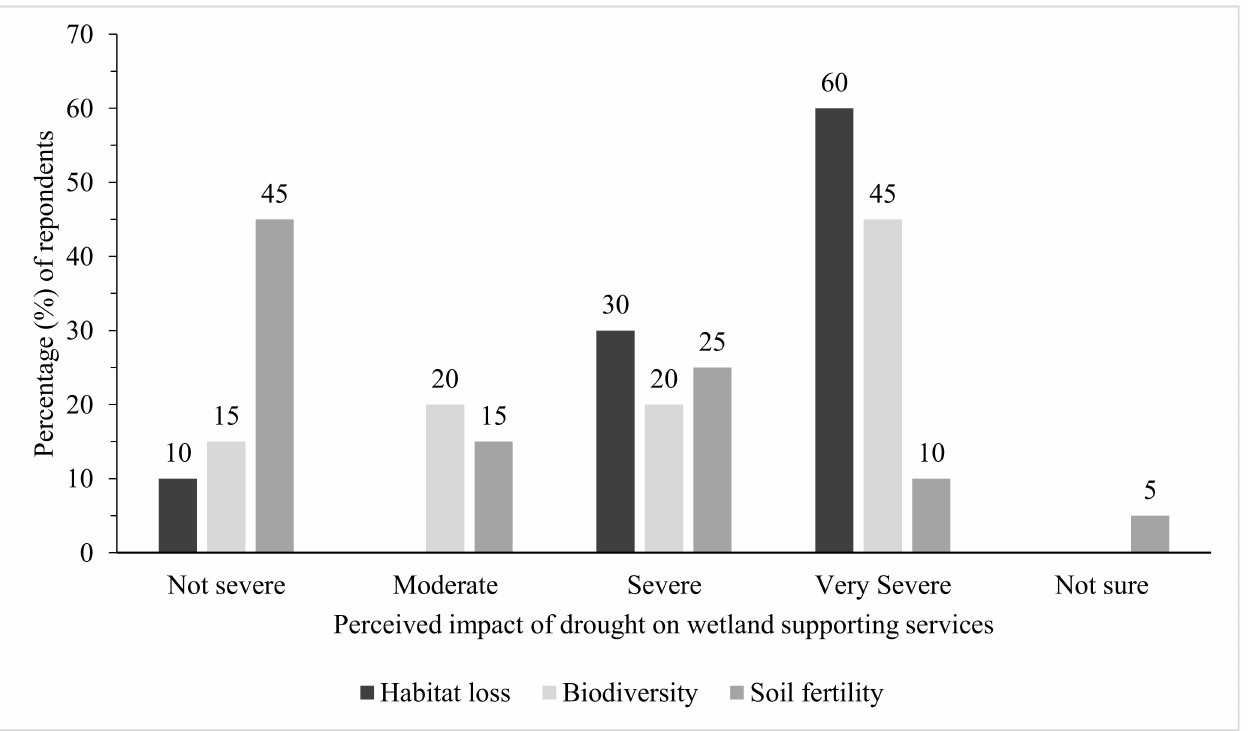
Figure 6. Perceived impact of drought on wetland supporting